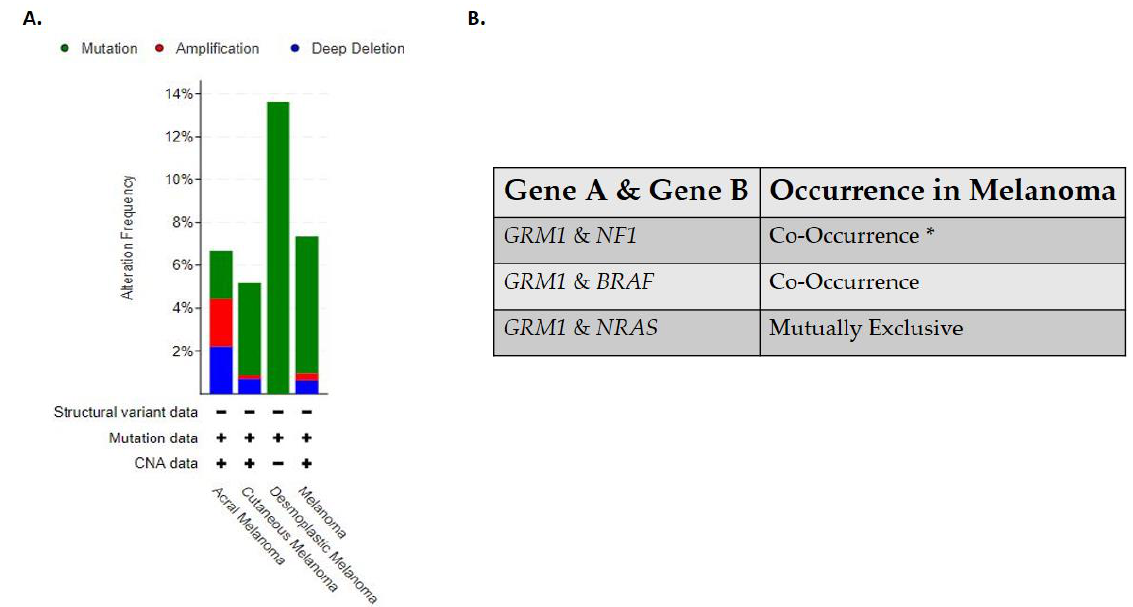
Figure 1. ( A ) Alterations in GRM1 that are found in human melanomas. ( B ) Occurrence of GRM1 with other melanoma driver genes in human melanomas. Analyses were done using cBioPortal.org (accessed on 15 July 2021). The skin dataset was chosen under query. All melanoma studies were included in the analyses, except Skin Cutaneous Melanoma (TCGA, PanCancer Atlas) due to the dataset overlapping with Skin Cutaneous Melanoma (TCGA, Firehouse Legacy). The sample size was 2386. * Significant.